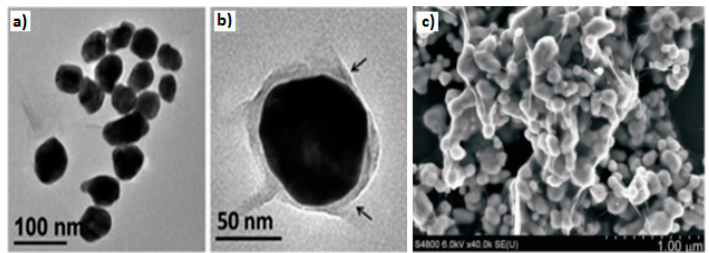
Figure 7. TEM images of the Au-encapsulated GO nanoparticles at ( a ) low magnification; ( b ) high magnification, adapted from [140], with permission from ©2013 Royal Society of Chemistry and ( c ) SEM image of GO-wrapped AuNPs, adapted from [141], with permission from ©2014, 2015 Wiley.